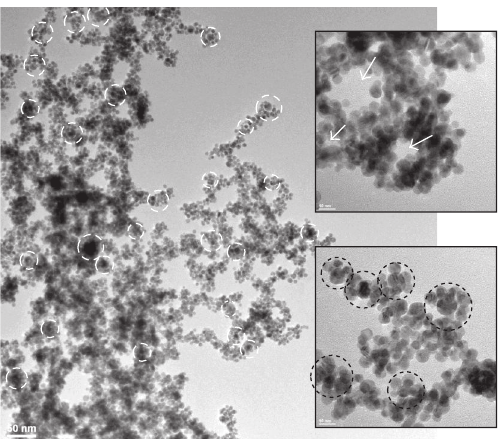
Figure 10: Typical self-assembling of Au-G6-1 nanoparticles, after 48h, with agglomerations (white and black circles) and interstitial channels (white arrows in upper